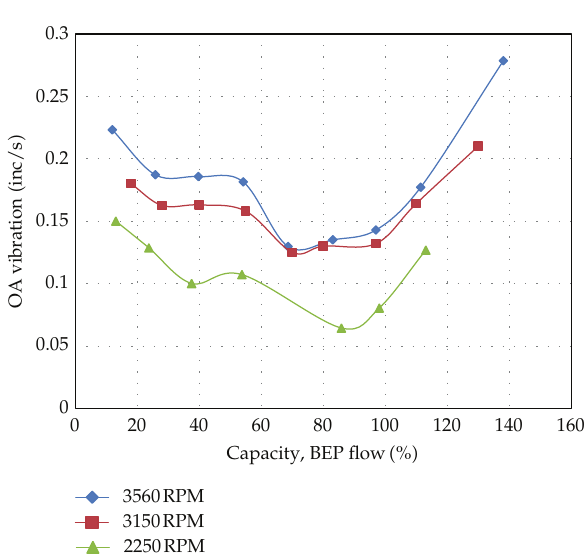
Figure 3: Test vibration level dates in di ff erent pump obtained by Stavale.